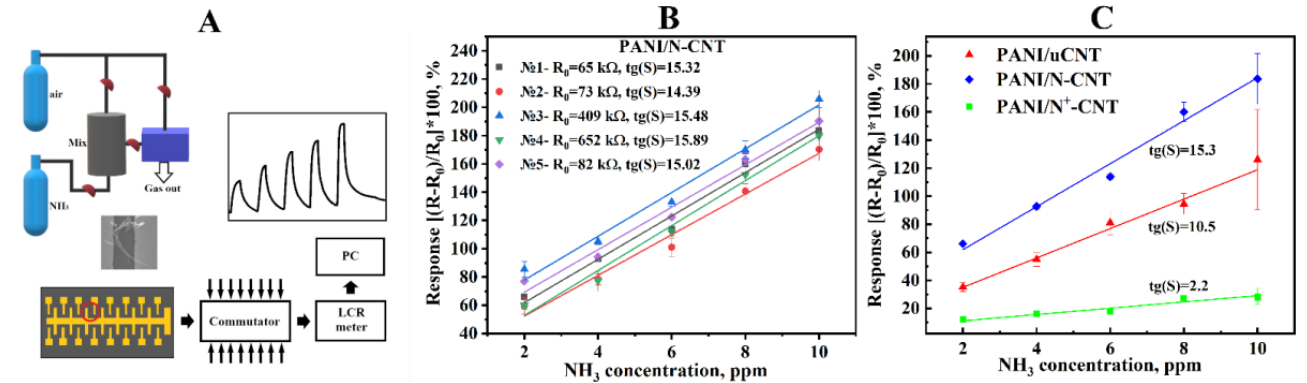
Figure 6. Schematic of the experimental platform ( A ); response of various PANI/N-CNT nanostruc- tures ( B ); response of typical PANI/uCNT, PANI/N-CNT and PANI/N + -CNT nanostructures ( C ).